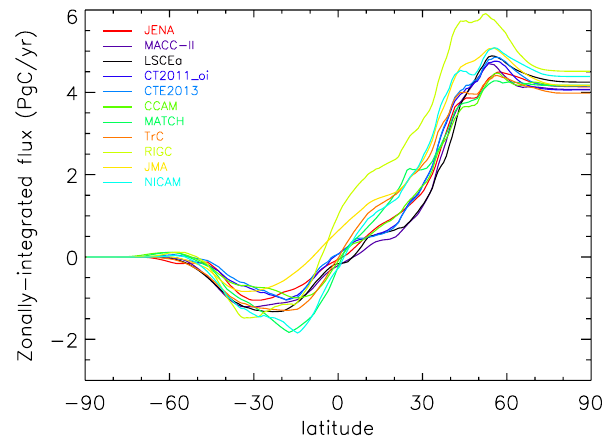
Fig. 3. Zonally integrated total carbon flux (natural land and ocean plus fossil fuel) accumulated from the South to the North Poles for the individual participating inversions averaged over the 2001 to 2004 time